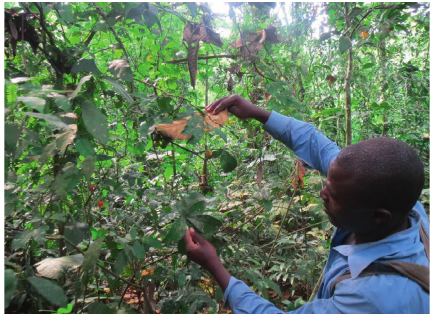
Figure 3: An illustration of how predation on monitored fruits was reduced. In this case, a leaf collected from the site was used to obscure sight of the fruits from above.